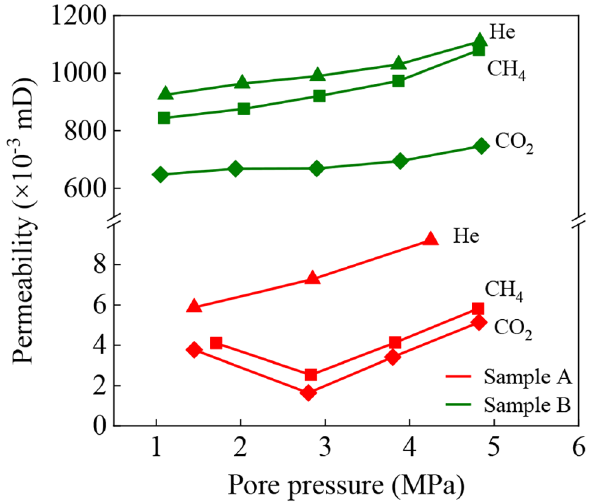
Fig. 10 Permeability versus pore pressure during gas injection with different initial permeability (Wang et al.